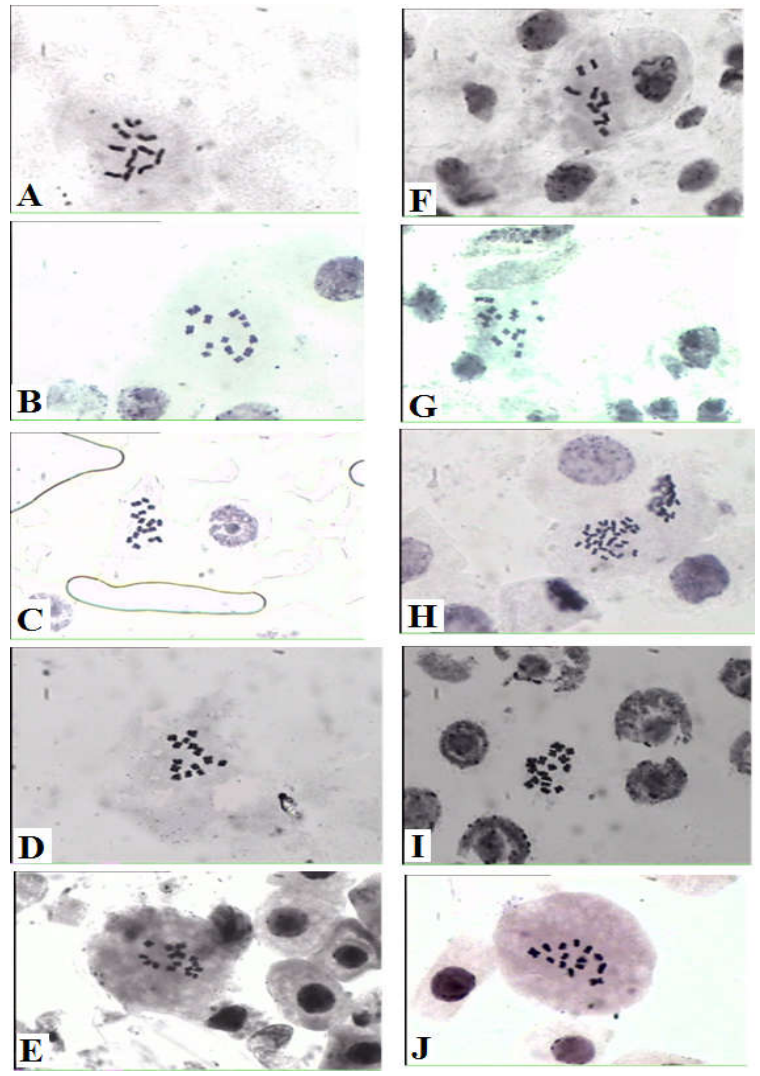
Fig. 1. Representative mitotic plates of Trifolium species: A) T. hirtum ; B) T. scabrum ; C) T. stellatum ; D) T. grandiflorum ; E) T. lappaceum ; F) T. repens ; G) T. campestre ; H) T. resupinatum ; I) T. tomentosum ; J)